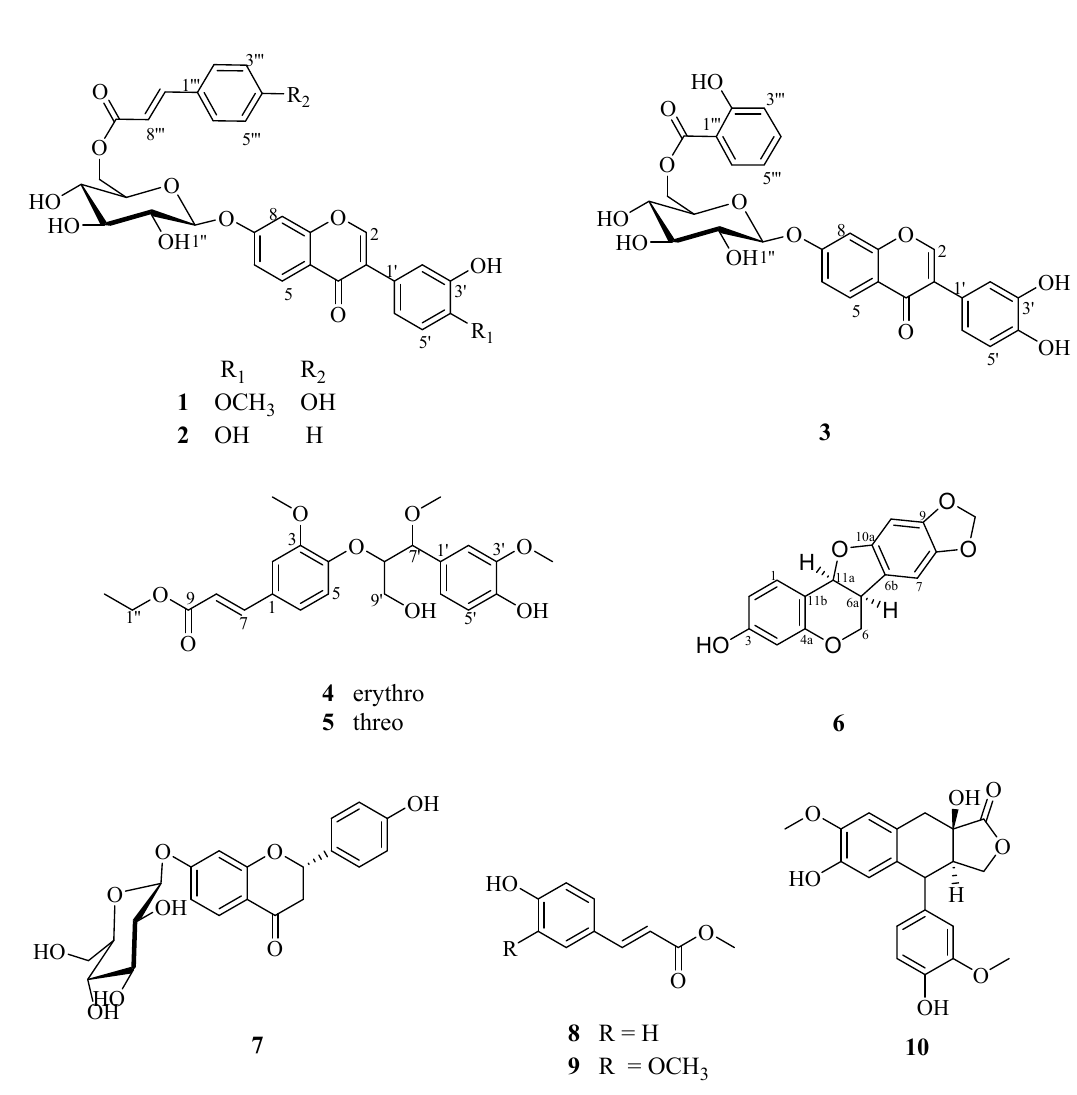
Figure 1. Structures of compounds 1 – 10 .